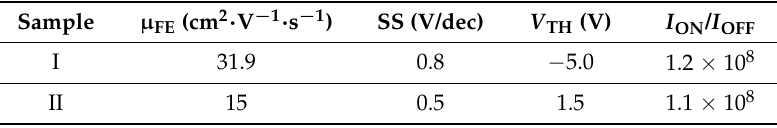
Table 1. Extracted performance parameters of the N-doped DSCL TFTs.